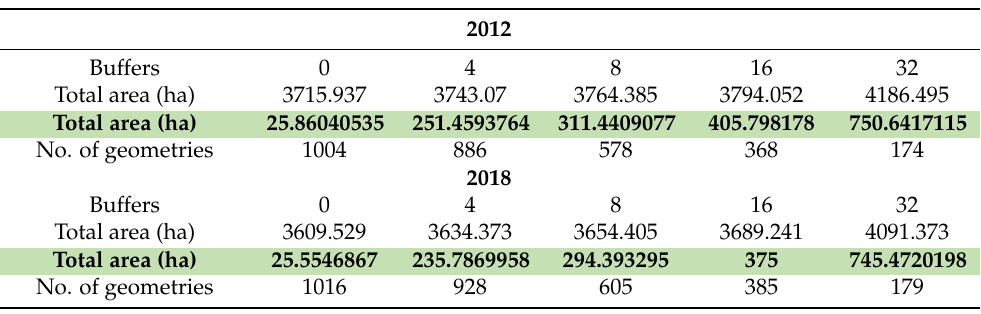
Table 2. Results of m eff for 2012 and